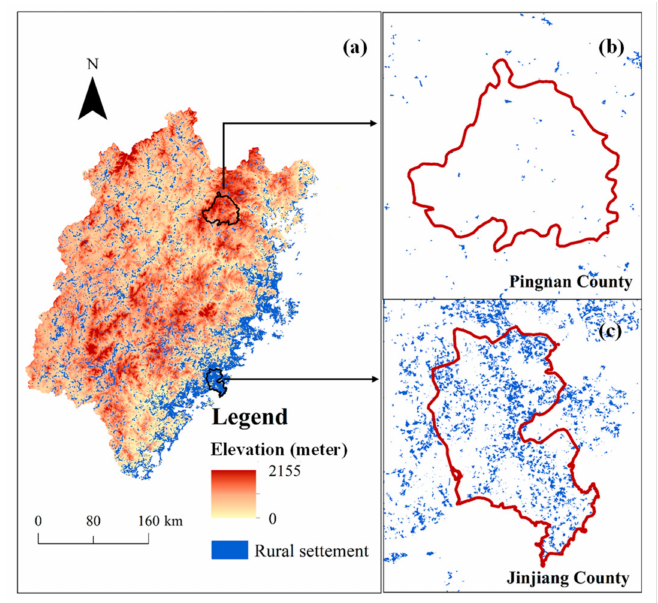
Figure 3. Distribution of rural settlements in ( a ) Fujian Province, ( b ) Pingnan County and ( c ) Jinjiang